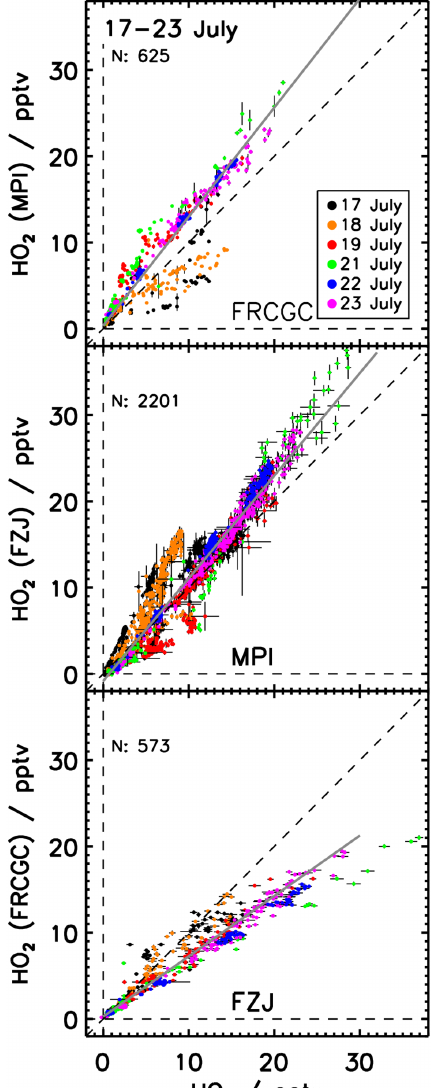
Fig. 9. Correlation of HO 2 mixing ratios measured during SAPHIR experiments on 17–23 July. 1min averaged data are shown. The dashed line is the 1:1 line and the solid lines show the result of linear fits. Like for the ambient data the scatter of the entire data sets is larger than expected from the precision of single data